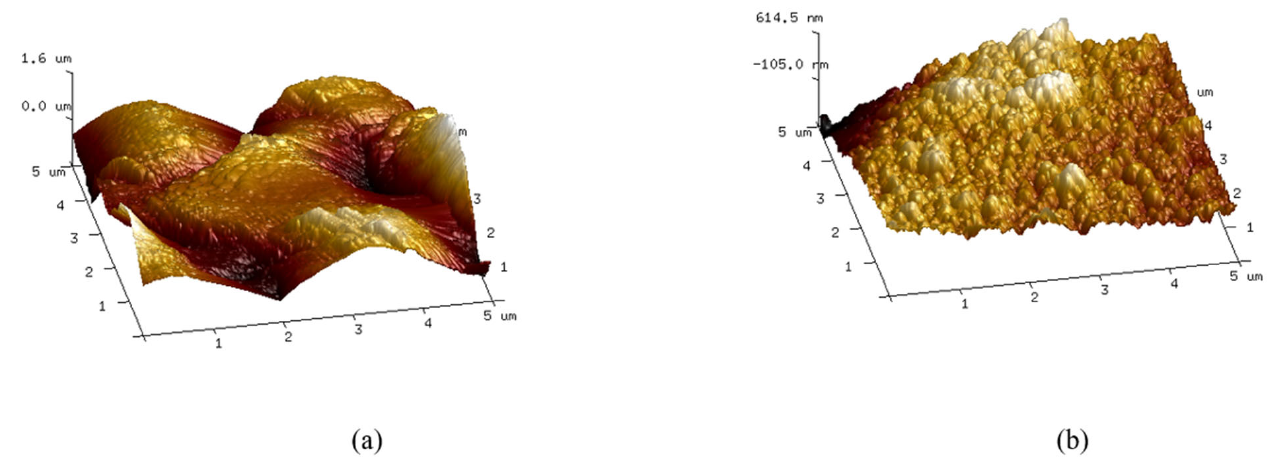
Figure 3. Large − scale (5 × 5 μ m) AFM images for ( a ) fs − laser ‐ treated Si and ( b ) ps − laser ‐ treated